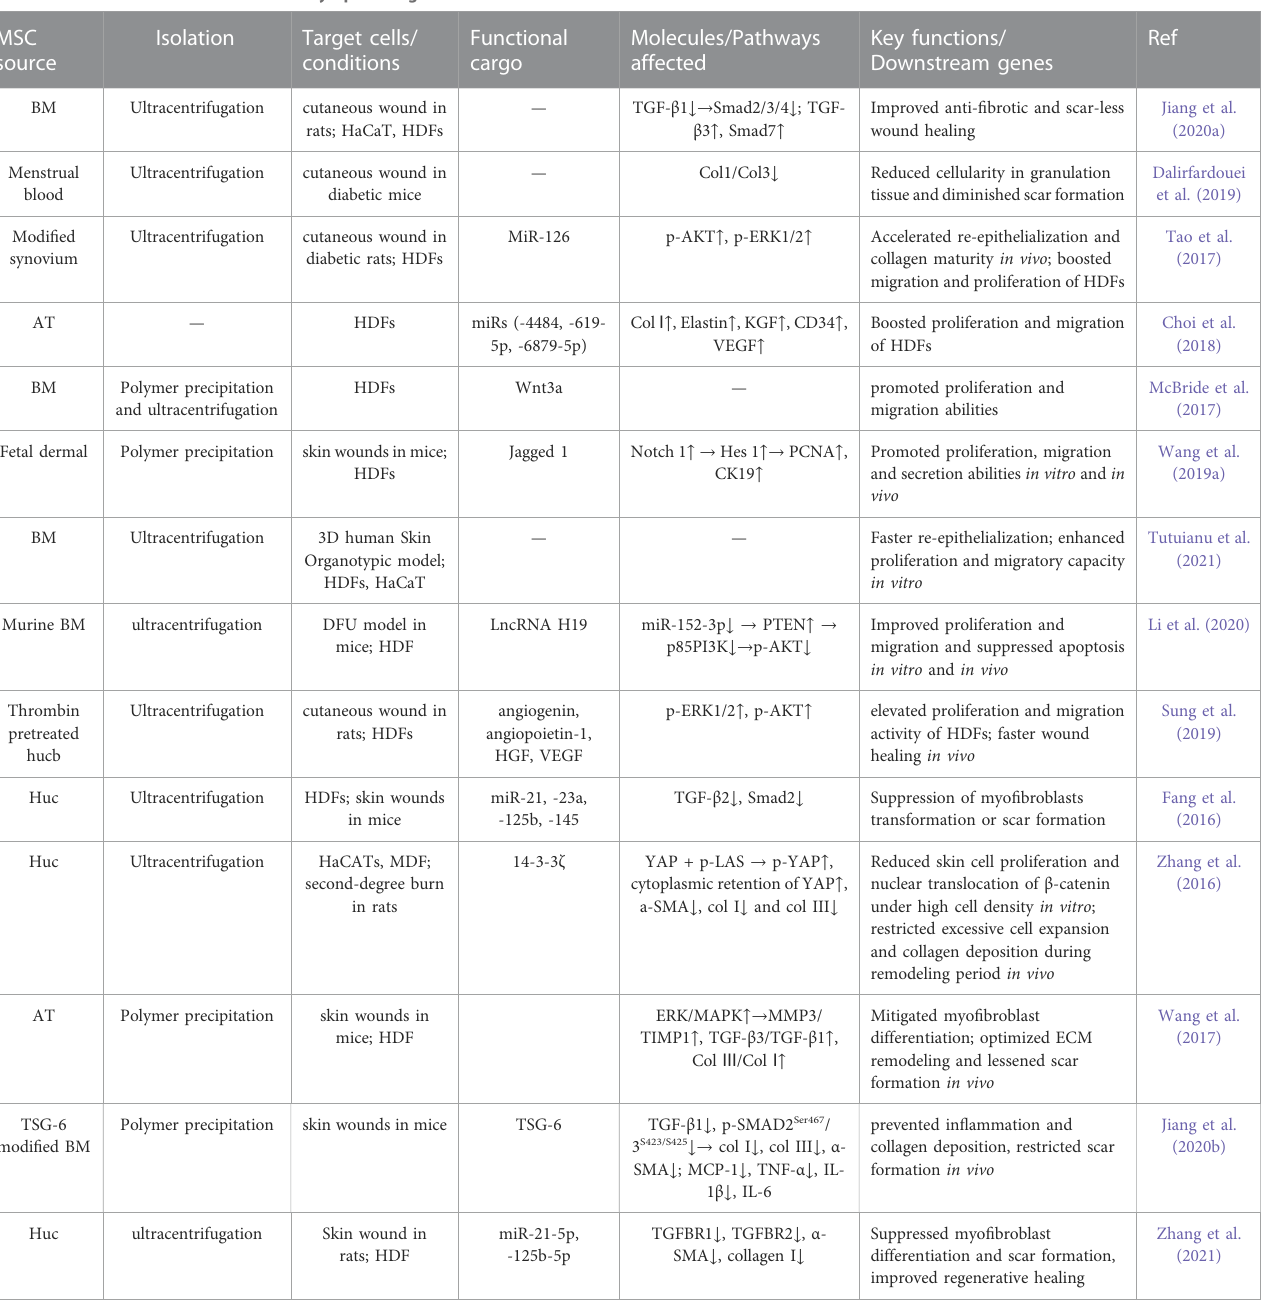
TABLE 6 MSC-sEVs exert curative effects by optimizing fi broblast behavior. MSC